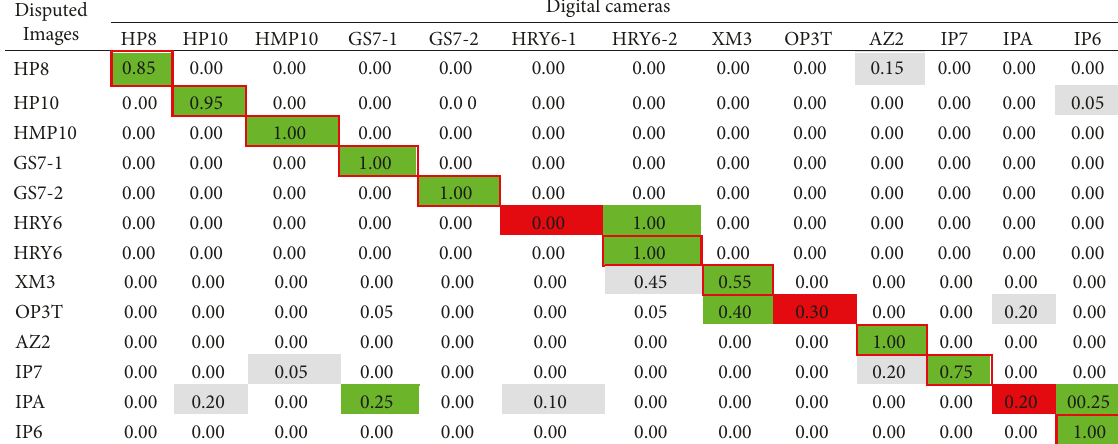
Table 8: Proposed method applied to the case study that includes natural images as disputed images when the PRNU is extracted from selected pixels and δ � 2 intensity